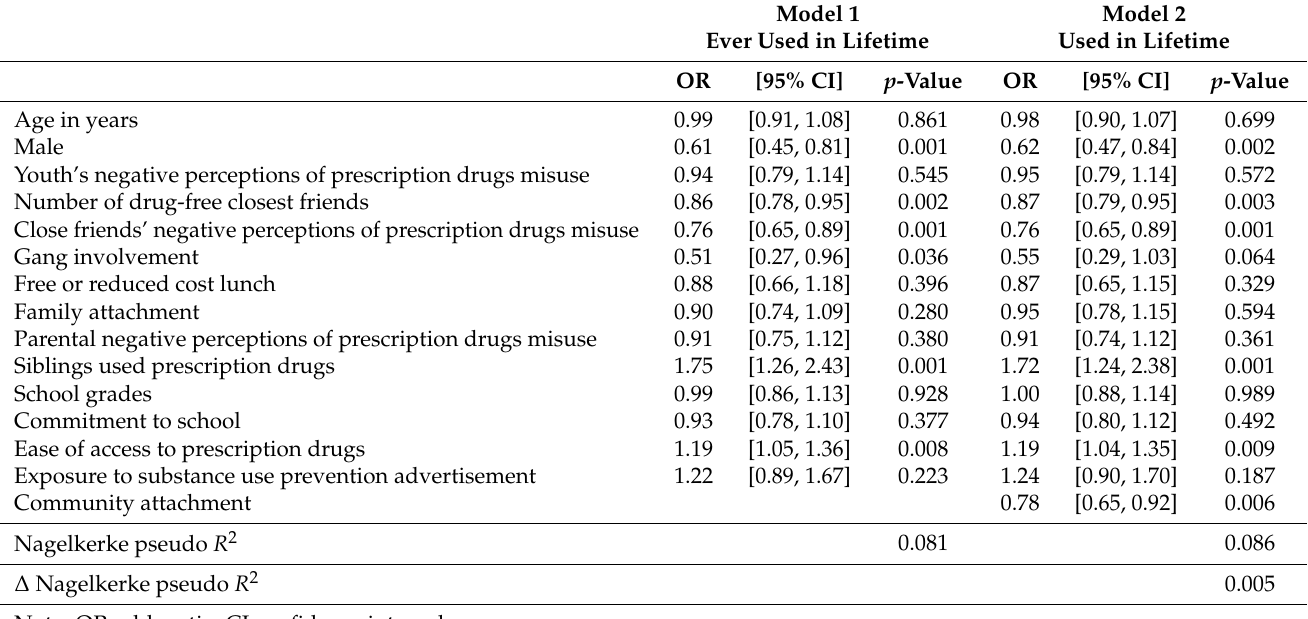
Table 2. Logistic regression results for American Indian youth lifetime prescription drug misuse (N =